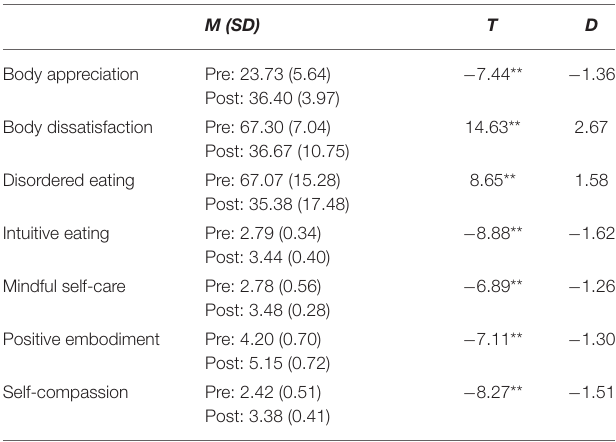
TABLE 3 | Pre- and post-intervention means, standard deviations, T -scores, and effect sizes for variables of interest. M (SD) T D Body